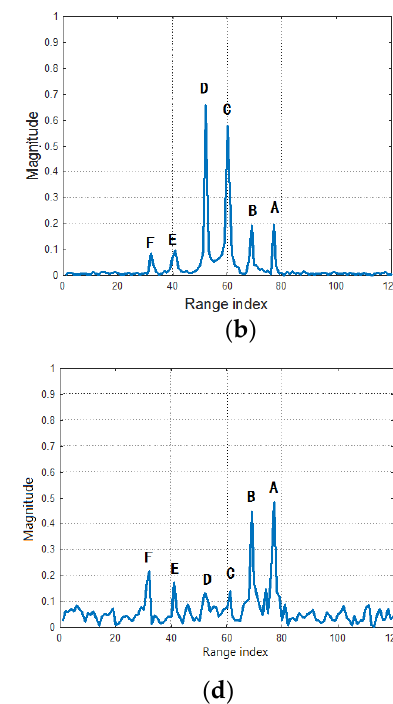
Figure 5. The HRRP sequence of the given target. Sensors 2018 , 18 , x FOR PEER REVIEW